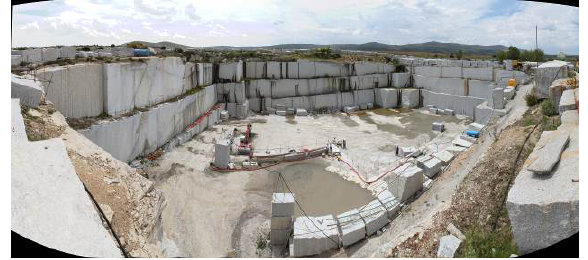
Figure 1. Panoramic view of the quarry